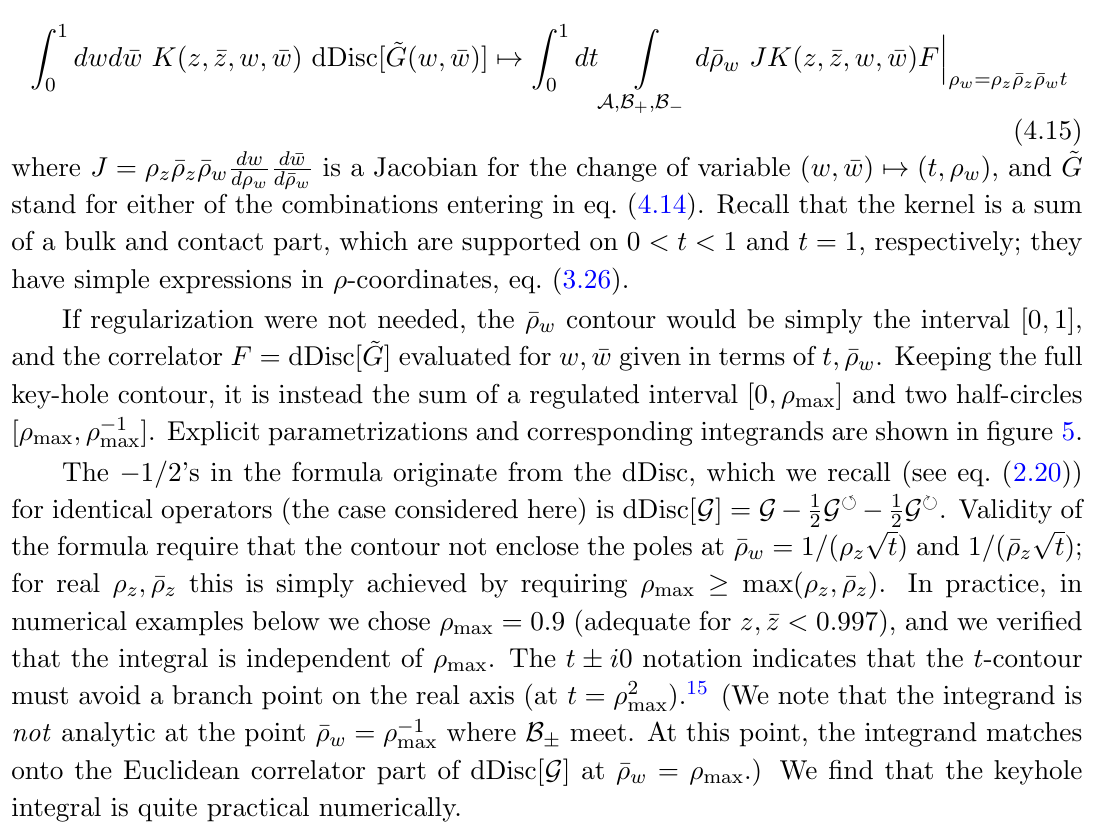
The solution is to integrate (cid:22) (cid:26) over a \keyhole" type contour. We write the result in w full in the case of identical external operators. This is best done in the following